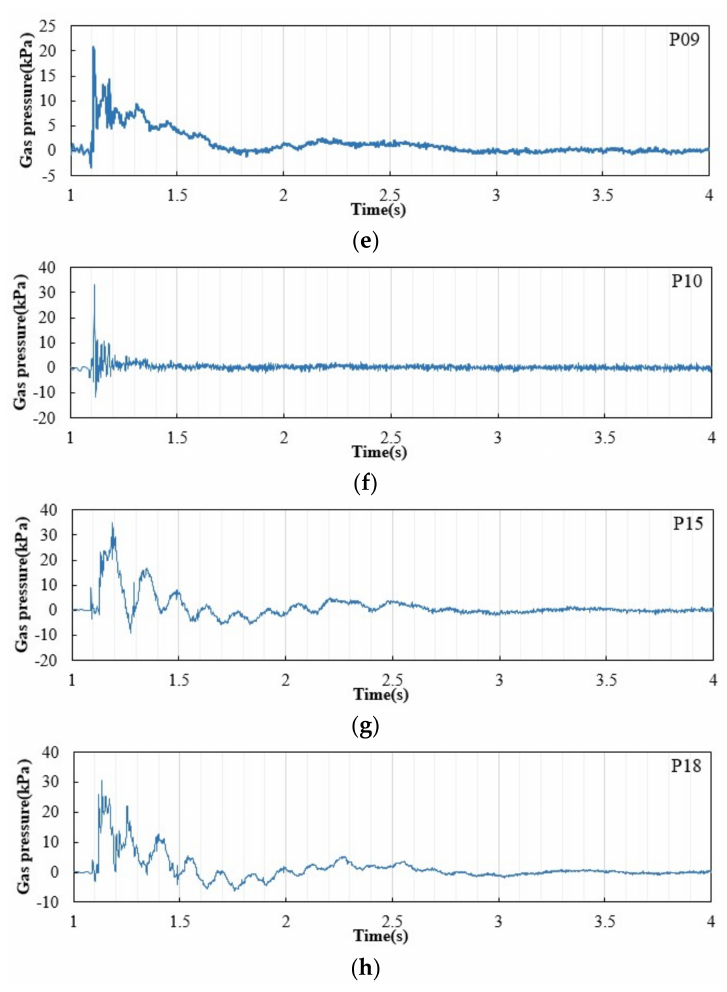
Figure 4. Evolution of gas pressure in roadway with different locations over time. ( a ) P01; ( b ) P03; ( c ) P06; ( d ) P07; ( e ) P09; ( f ) P10; ( g ) P15; ( h )